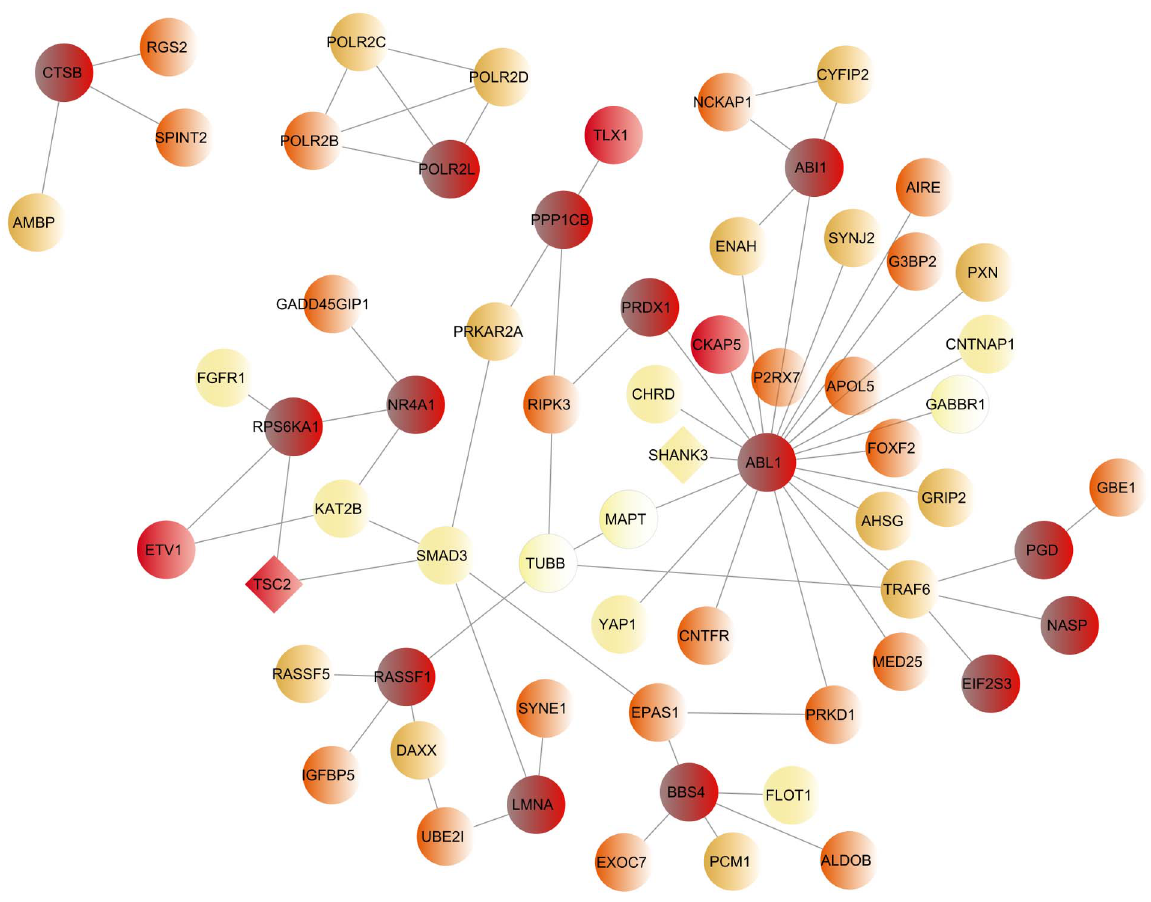
Figure 3. ASD top scoring gene network. This network illustrates the 14 top scoring genes included in the ASD LCC and their first neighbors. Nodes are colored based on a score reflecting their presence in the second ASD dataset and in the 6 unrelated diseases LCCs. A darker color represents a higher score, which means a higher specificity for ASD.